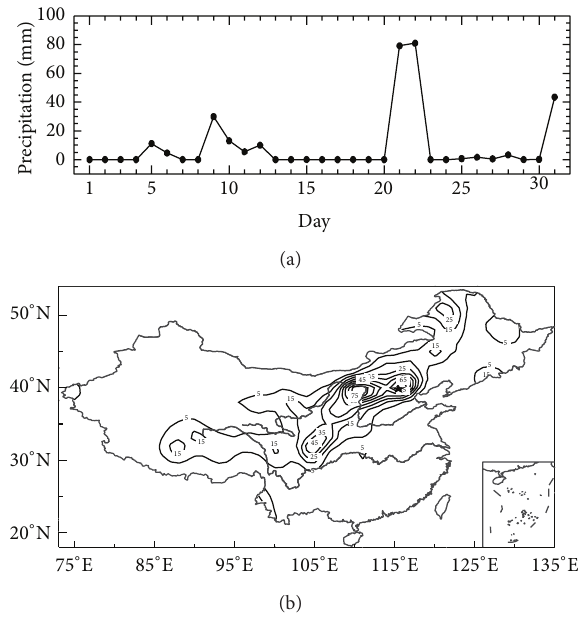
Figure 1: (a) Daily precipitation (unit: mm) evolution in Beijing (54511) during July 1–31, 2012. (b) The distribution of Chinese precipitation (unit: mm; contour intervals: 10mm) on July 21, 2012. ThepentagramisonbehalfofBeijinglocation.Theprecipitationwas accumulated in 24